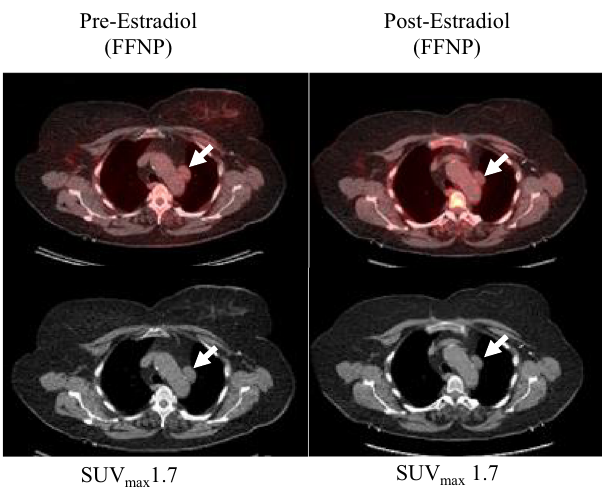
Fig. 2 Nonresponder. A woman with ER + /PR − /HER2 − invasive ductal carcinoma post neoadjuvant ET and breast conserving surgery, who developed metastatic disease to left prevascular and aortopulmonary lymph nodes. She was treated with an aromatase inhibitor after the estradiol challenge test but developed progressive disease. Selected fused transaxial FFNP-PET/CT (top) and CT (bottom) images at baseline show minimal FFNP uptake in the prevascular lymph node metastasis (arrows). One day after estradiol, tumor FFNP uptake measured as the maximum standardized uptake value (SUV max ) (arrows) is unchanged.